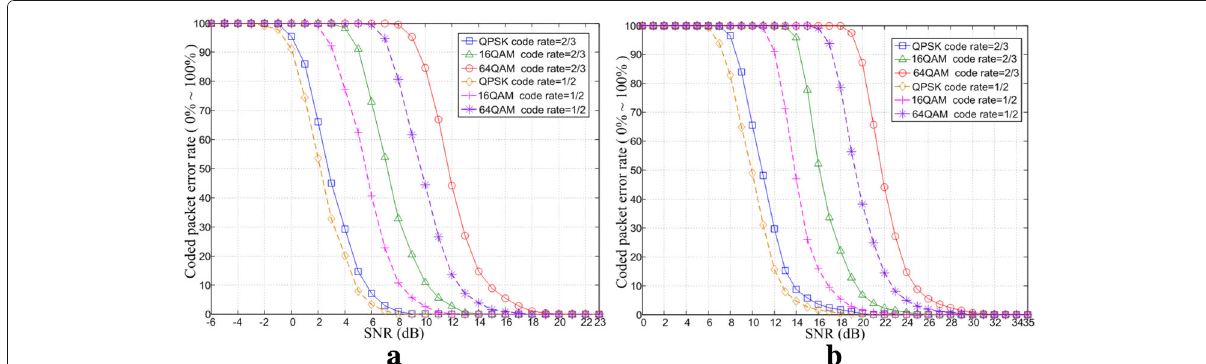
Fig. 10 Coded PER (TGn channel B). a Coded PER with beamforming. b Coded PER without beamforming